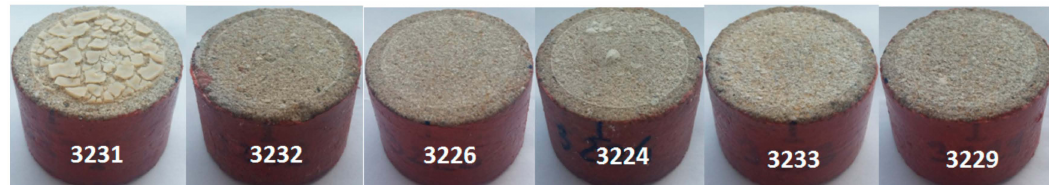
Figure 5. The cores surface after damage with